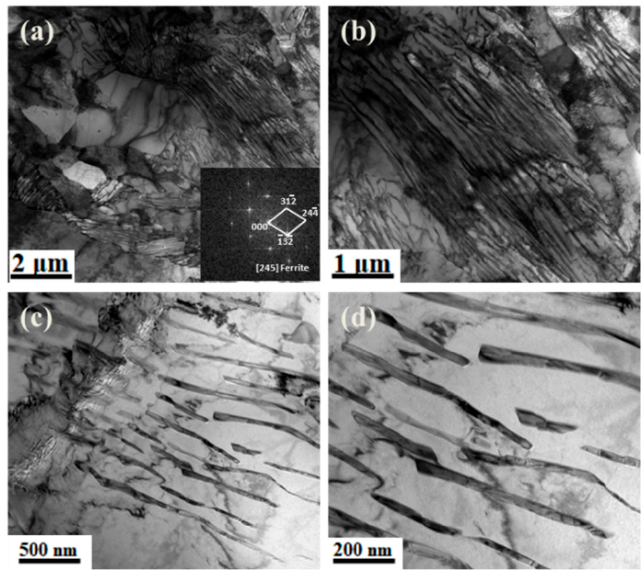
Figure 5. TEM morphology of ferrite and pearlite in experimental steel at final cooling temperature of 650 °C. ( a ) Morphology of ferrite and pearlite, ( b – d ) enlarged figure.